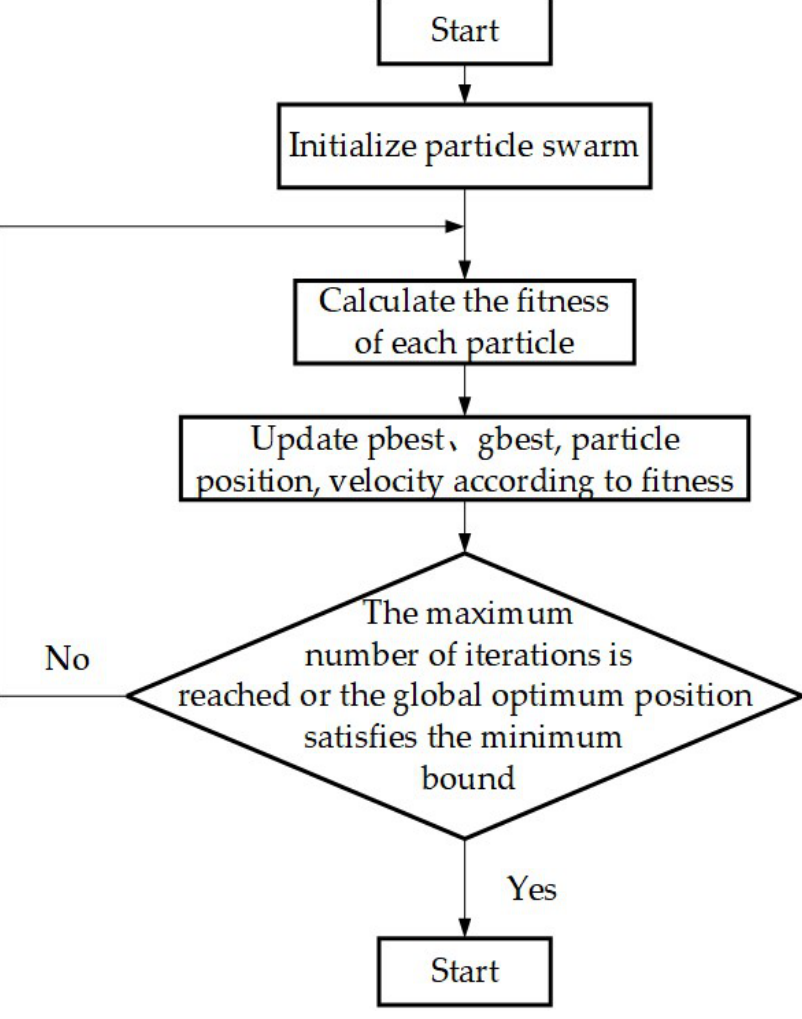
Figure 2. Flow chart of the standard PSO algorithm.